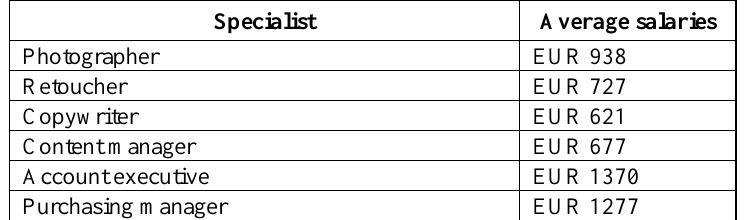
Table 1. Average Salaries of Specialists in Moscow, Russia (authors’